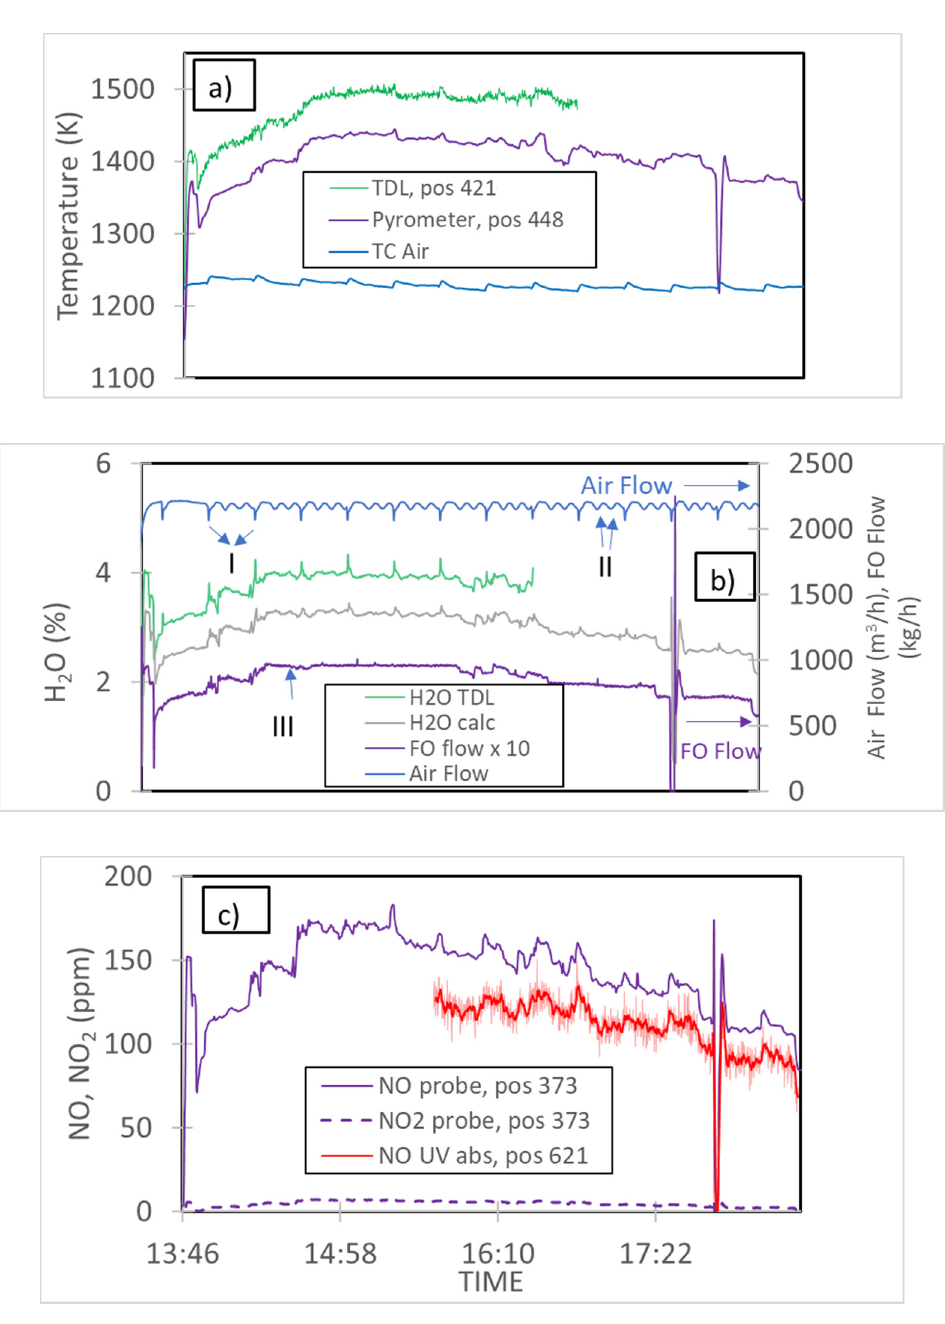
Figure 2. Online measurements of T (TDL, Suction pyrometer, TC) ( a ), H 2 O (TDL) and flows of process air and FO ( b ), NO (UV absorption) and NO and NO 2 (Probe) ( c ) during the combustion of FO (Day 1). Position number in the legend (pos nnn) shows the distance in cm from the beginning of the ECF to the measurement position.